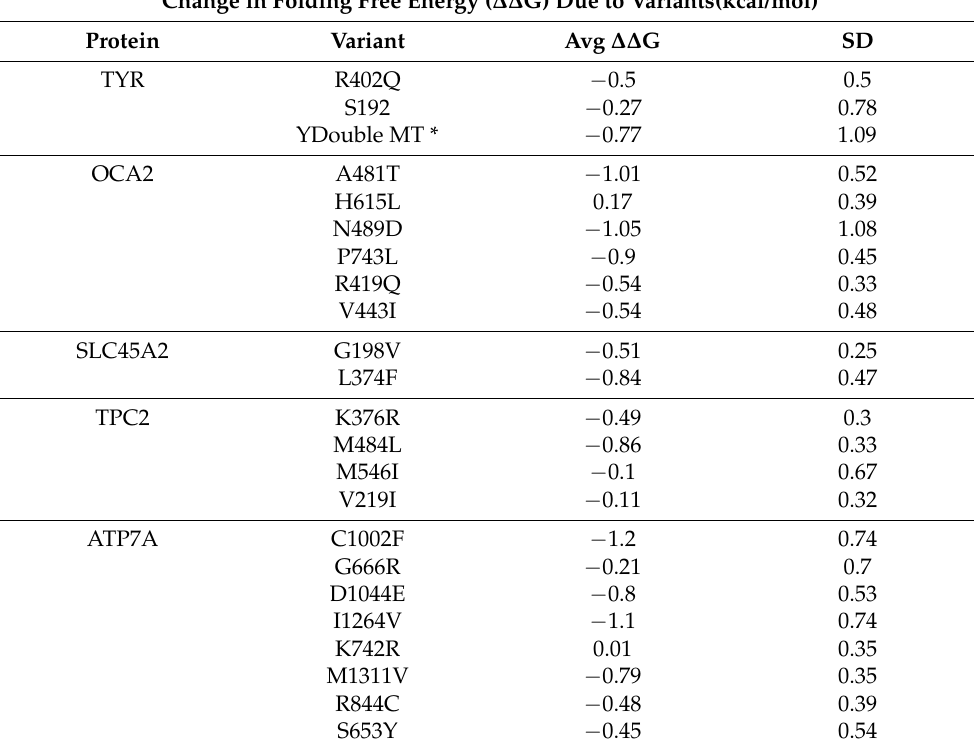
Table 1. Change in folding free energy due to variants. Change in Folding Free Energy ( ∆∆ G) Due to Variants(kcal/mol) Protein